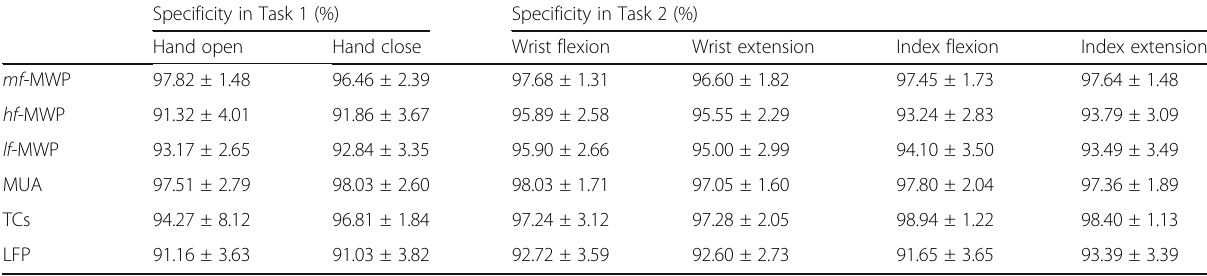
Table 6 Specificity of the individual decoders when using different features as input Specificity in Task 1